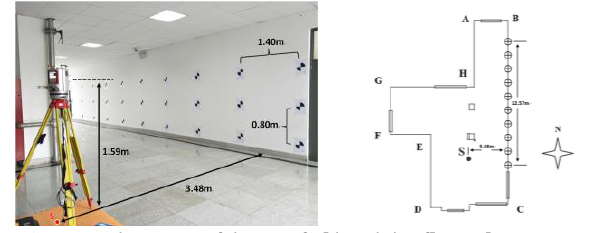
Figure 4. The setup of the test field and the floor plan To the convenience of the point cloud processing, the point cloud of the targets is cropped (Figure 5). All of the 30 targets are then localized using Leica Cyclone 6.0.3 and used as the ground truth.